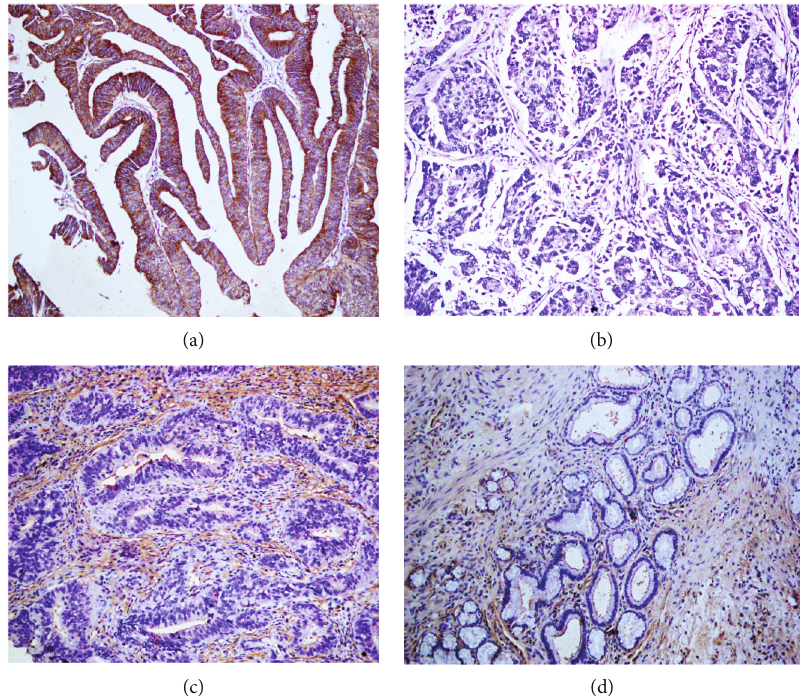
Figure 1: Immunohistochemical staining of DSG1, × 200. (a) Positive expression of DSG1, moderately di ff erentiated EHCC. (b) Negative expression of DSG1, well di ff erentiated EHCC. (c) Positive expression of DSG1, pericancerous tissues. (d) The positive expression of DSG1,